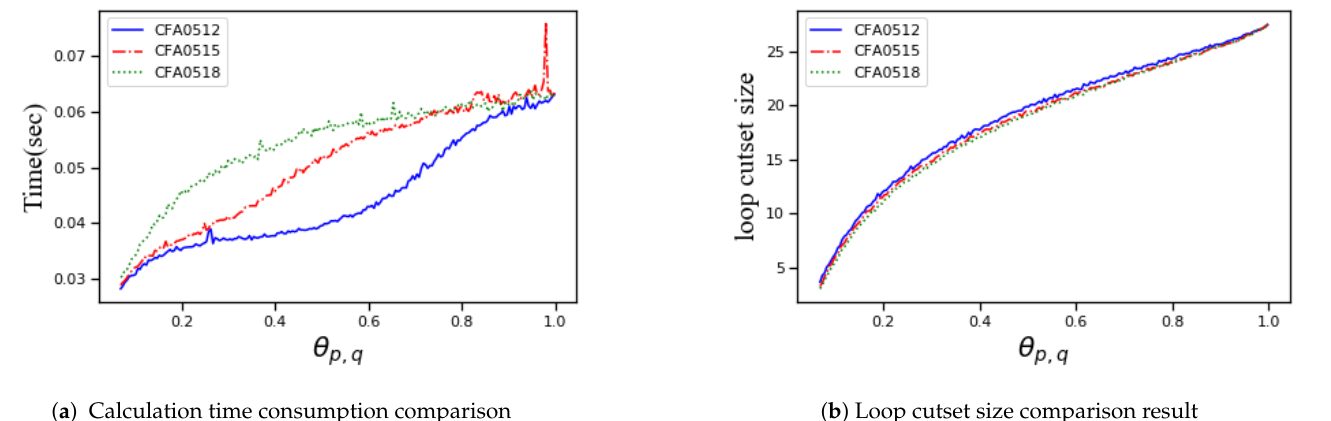
Figure 7. Keep the µ unchanged and change the value of ω , the comparison chart of the results of the CFA